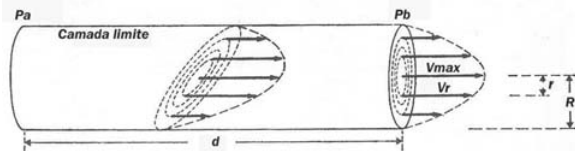
Fig. 3 - Fluxo laminar no interior de um tubo cilíndrico. Observar que o fluxo é determinado pelo gradiente de pressão, e que cada anel de fluxo tem velocidade própria, gerando-se assim atrito interno (viscosidade), entre as várias camadas de líquido em movimento. Modificado de Silva Jr MR. Fisiologia da circulação. 2ª ed. São Paulo:Edart;1977. p.9